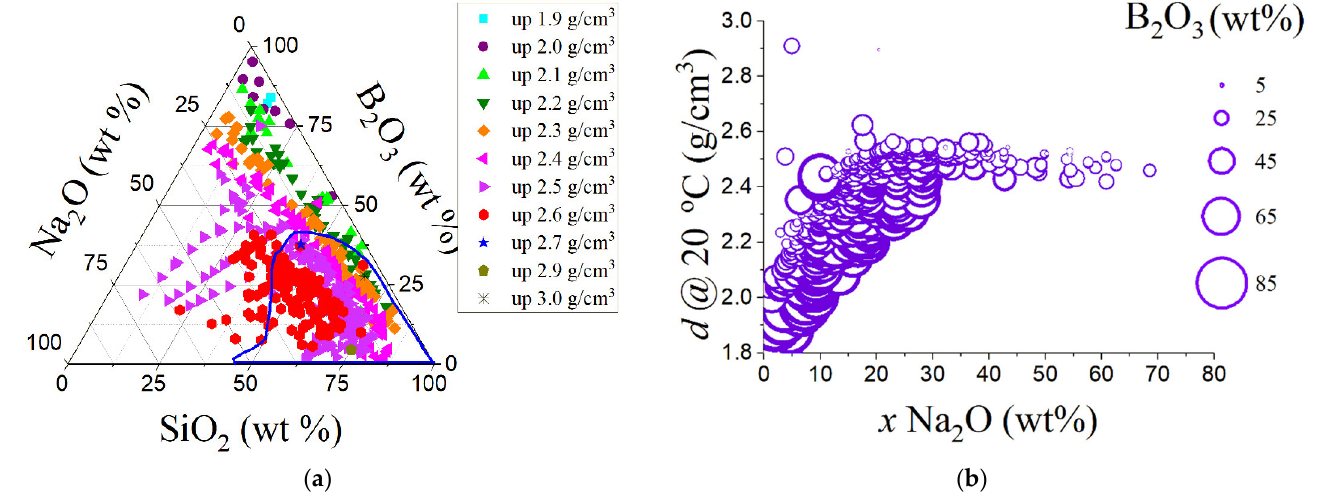
Figure 7. ( a ) Ternary diagram of selected sodium borosilicate glasses from Sciglass TM database (version 7.9). The blue region corresponds to approximately the density behavior from a plethora of sodium borosilicate waste-immobilization glasses. ( b ) The density dependence on sodium oxide content at 20 °C. Density shows a high increase, from 1.8 to 2.5, changing the sodium oxide content up to 30 wt%, and maintaining this fixed value for higher sodium concentrations.